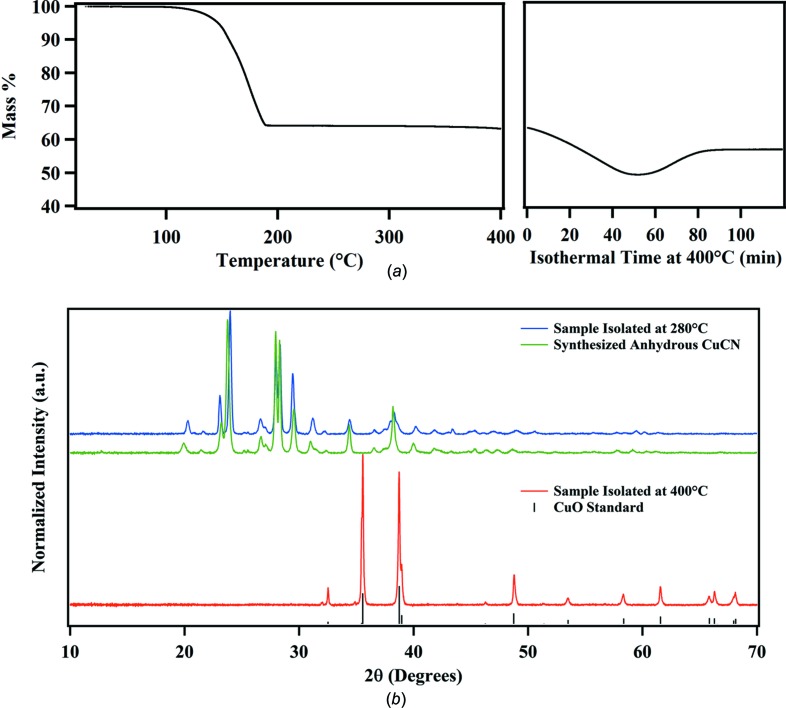
(a) Thermogravimetric analysis data for [meoenH]Cu2(CN)3. The temperature was ramped at 4 °C min−1 to 400 °C (left), producing the first mass loss of 36%. The temperature was held at 400 °C for 120 min to produce the second mass loss of 52% of the initial mass in an isothermal step (right). (b) PXRD data collected after TGA of samples heated to 280 and 400 °C. The PXRD pattern for our synthesized CuCN and a standard pattern for CuO (COD 90144580) are also shown.